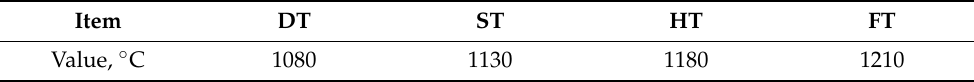
Table 3. Softening and melting properties of coal ash.